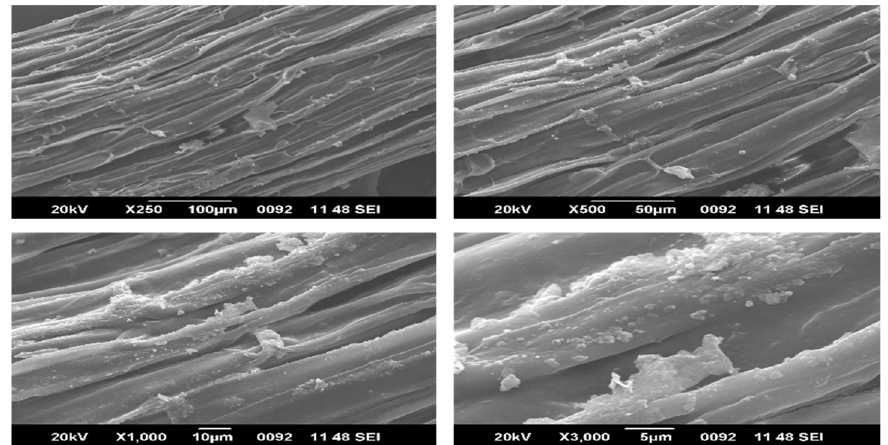
Figure 6. SEM images of raw Zm fi bres.